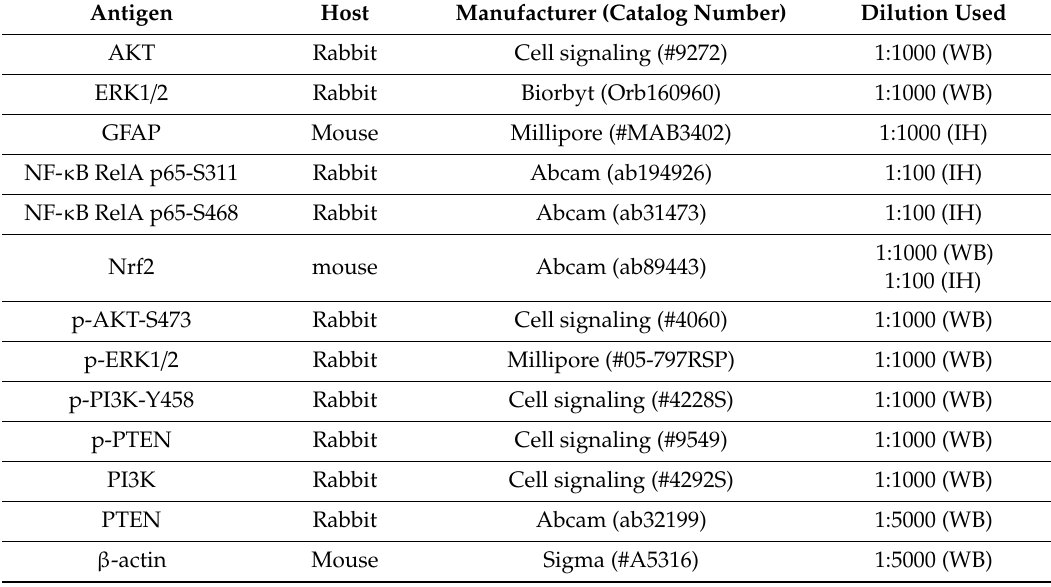
Table 1. Primary antibodies used in the present